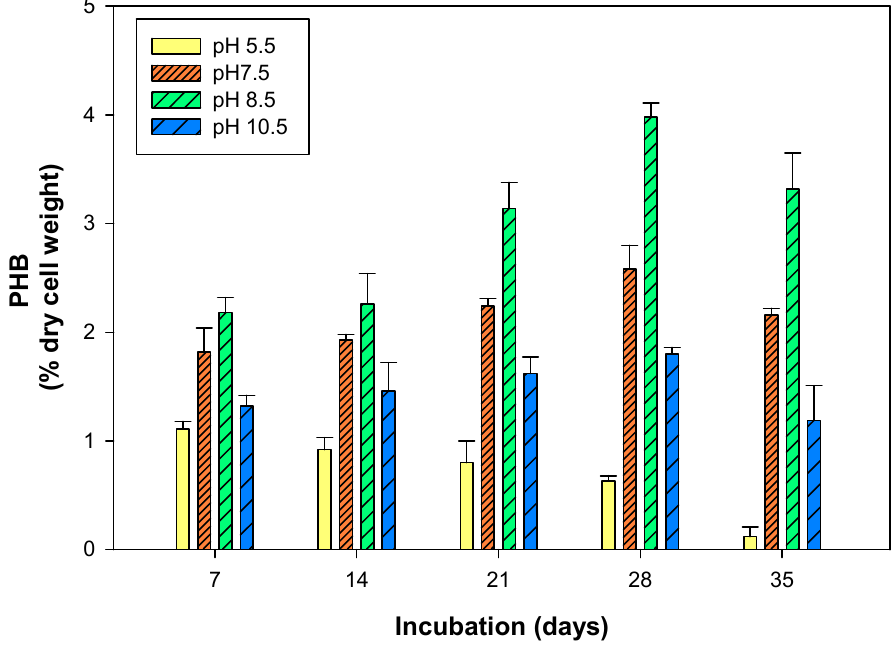
Figure 5. Production of PHB in S. geitleri in response to pH. Values are the mean ( n = 3) ± SD.